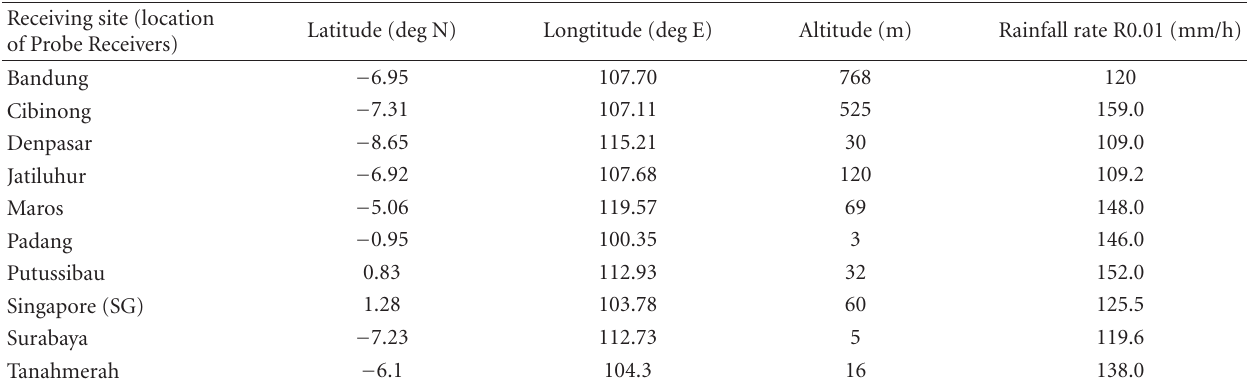
Table 3: Scenario 2; receiving sites across